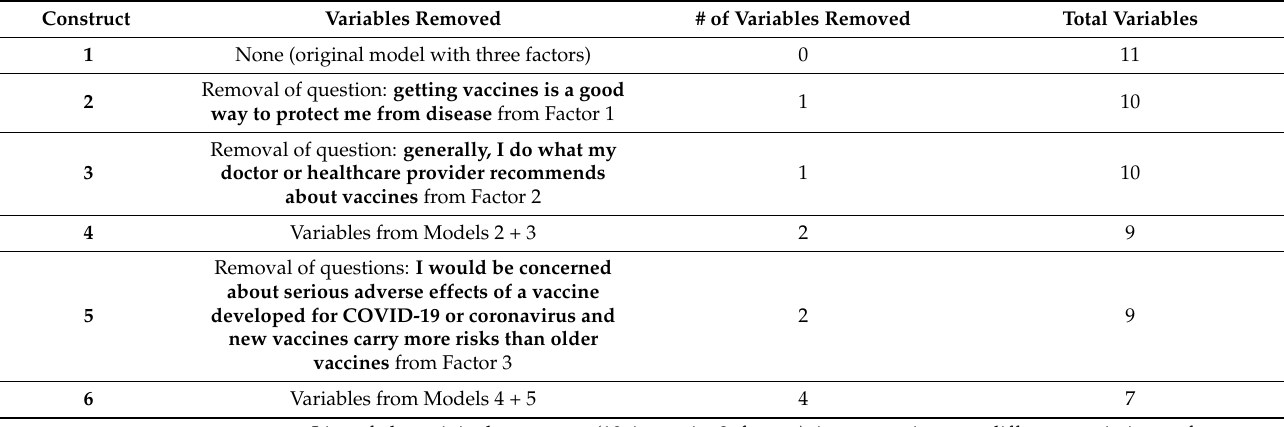
Table 3. List of different confirmatory factor analysis constructs.